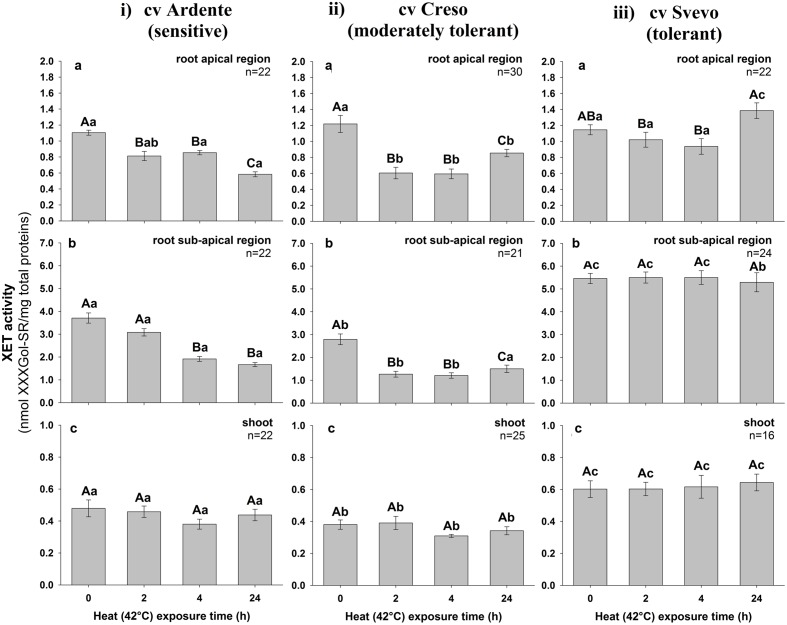
Extractable XET activity in excised segments of (a) root apical region, (b) root sub-apical region, and (c) shoot from 3-day-old durum wheat (T. durum Desf.) seedlings of (i) Ardente, (ii) Creso, and (iii) Svevo cultivars, differing in heat tolerance. The seedlings of each cultivar were subjected to heat (42°C) stress for 2, 4, and 24 h. XET activity is expressed as nmol of xyloglucan–XXXGol-SR formed by the transglycosylation reaction, per mg of total protein. The results represent the average of n independent replications ± standard error. Different capital letters above bars indicate statistically significant differences (p < 0.05) between time points within the same cultivar, while lower case letters indicate statistically significant differences across cultivars in response to stress duration, as determined by the Tukey’s post hoc test.